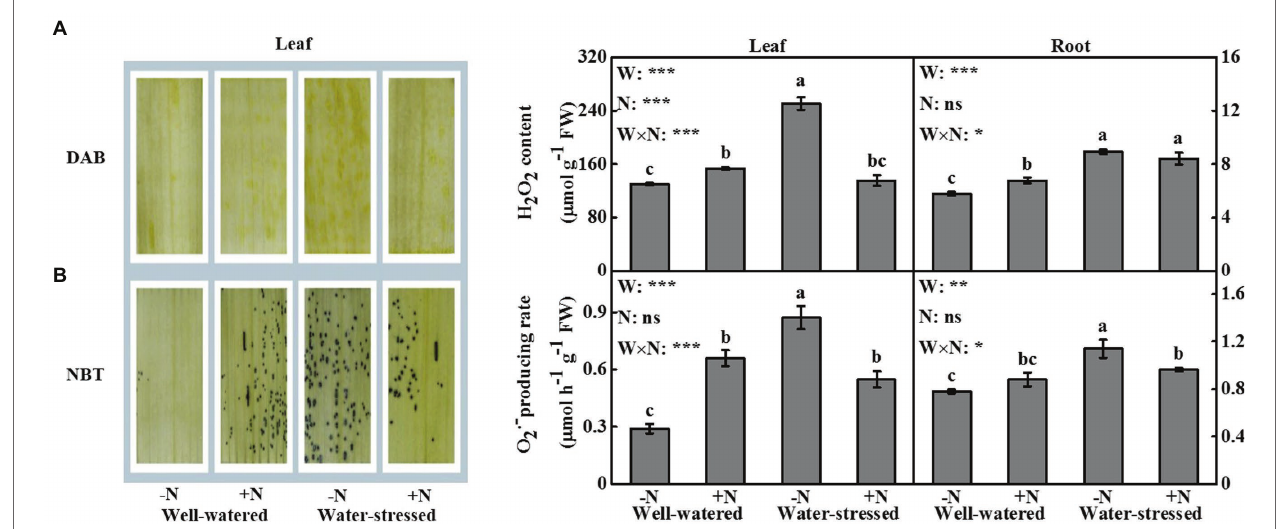
FIGURE 5 | In situ detection of reactive oxygen species (ROS) in leaves, and quantitative measurements of ROS in leaves and roots of Fargesia denudata for N non-deposition ( − N) and N deposition (+N) treatments with and without drought stress. (A) hydrogen peroxide (H 2 O 2 ) accumulation, (B) producing rate of superoxide - O · 2 ). F W , water effect; F N , N deposition effect; and F W × F N , interactive effect of water and N deposition. Values with different letters are significantly different at anion (